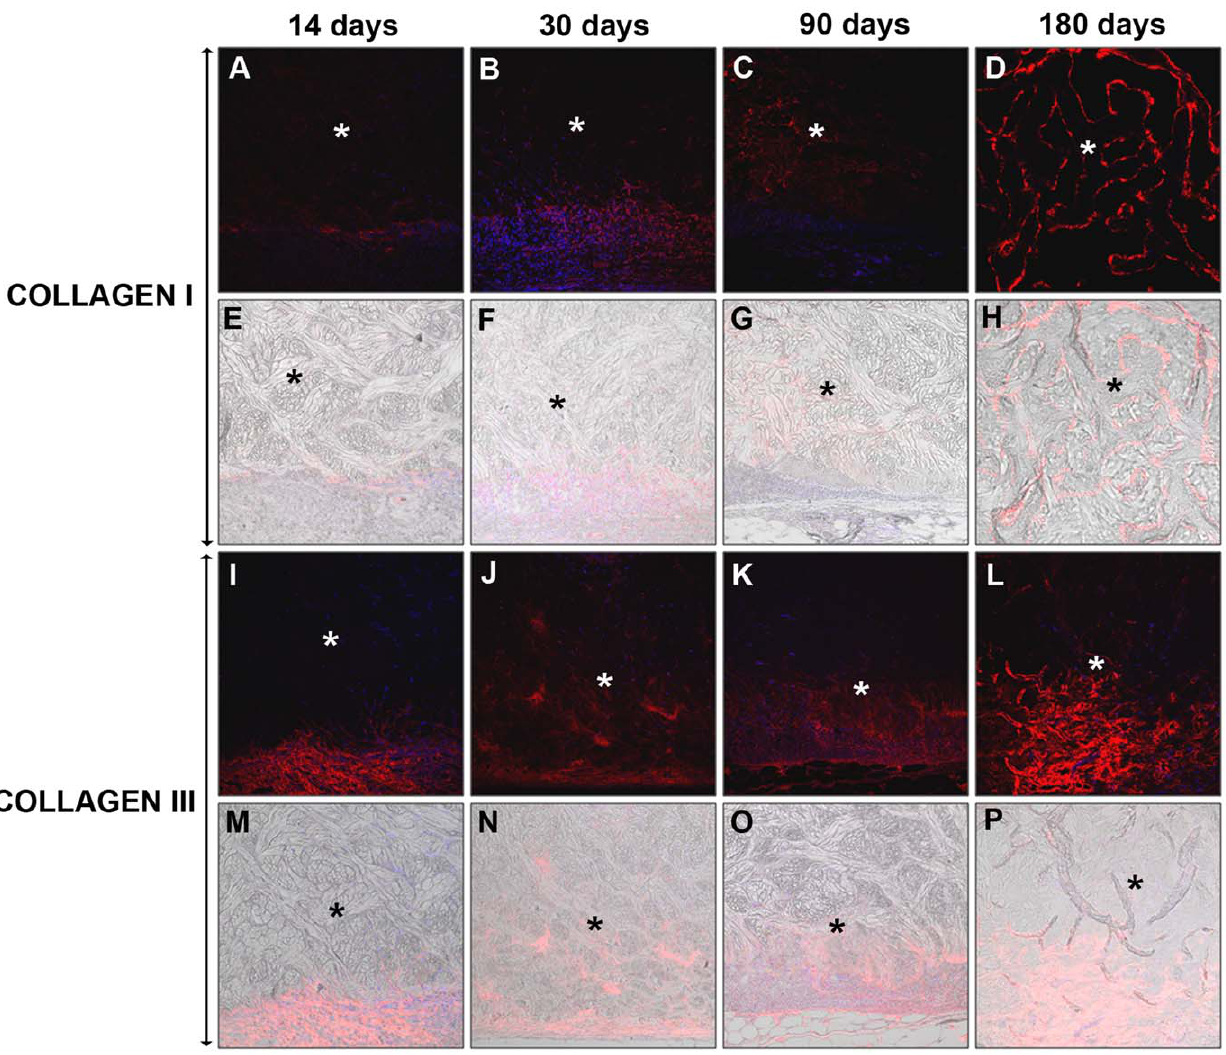
Figure 7. Immunodetection of the neoformed collagen I and III in Strattice H . Mature Collagen I (A–H) and immature Collagen III (I–P) immunofluorescence at 14, 30, 90 and 180 days post-implantation. The neoformed collagen appears in red and the cell nuclei (stained with DAPI) appear in blue. The DIC images that identify the biomaterial appear translucent (E–H and M–P). Confocal light microscopy (200 6 ). (* Biomesh).